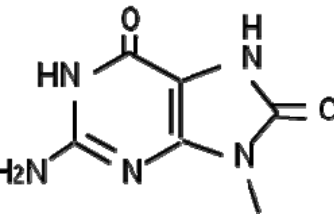
Figure 2. Structure of 7,8-dihydro-8-oxoguanine (8-oxo-Gua). 8-oxo-Gua is formed by hydroxylation of guanine at the C-8